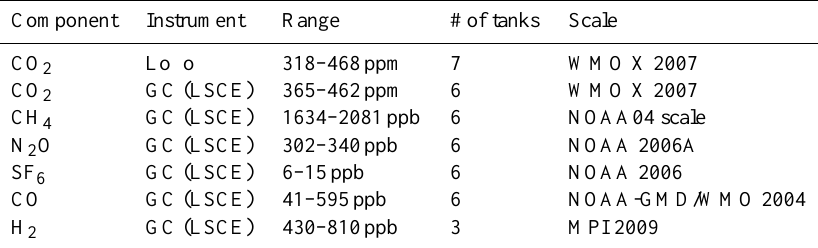
Table 3. Primary calibration scales at the LSCE central lab, which are used to calibrate the station standards. CO 2 calibration of the working standards is generally performed with the Loflo (NDIR) analyser. The other gases are calibrated by GC